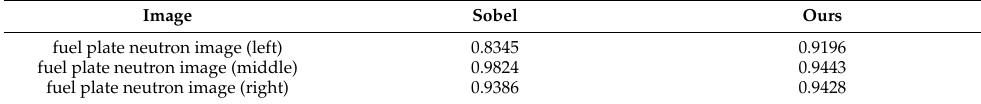
Table 3. Result of the edge evaluation method based on FOMs. Image